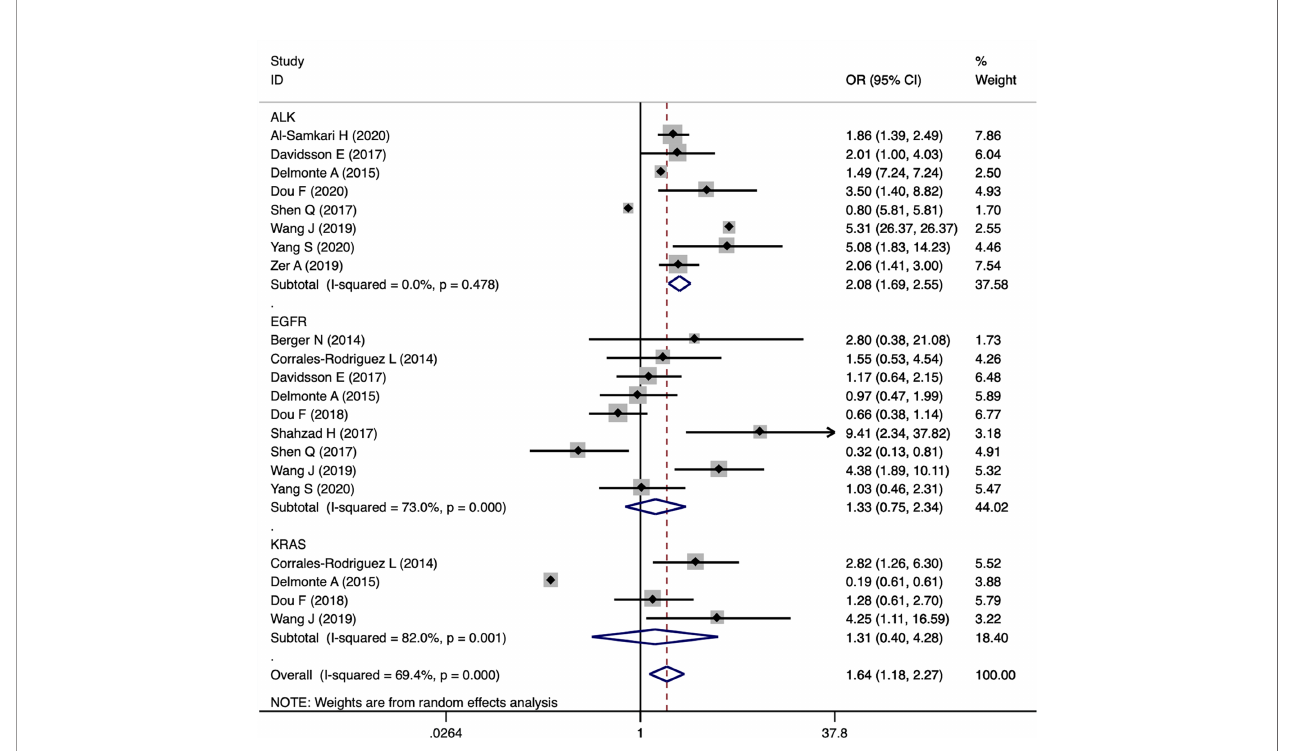
FIGURE 3 | Forest plot demonstrating the association of driver genes with VTE